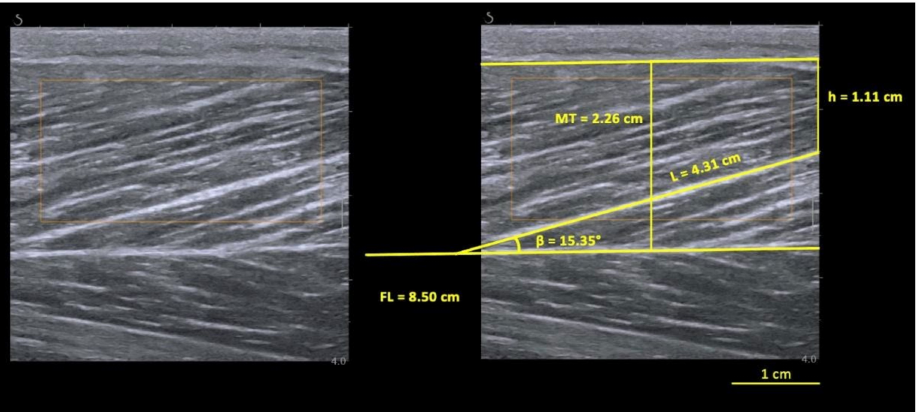
Figure 1. Biceps femoris long head (BFlh) architecture, measured at pre-task active condition. L, observable fascicle length; h, height; β , pennation angle; MT, muscle thickness; FL, fascicle